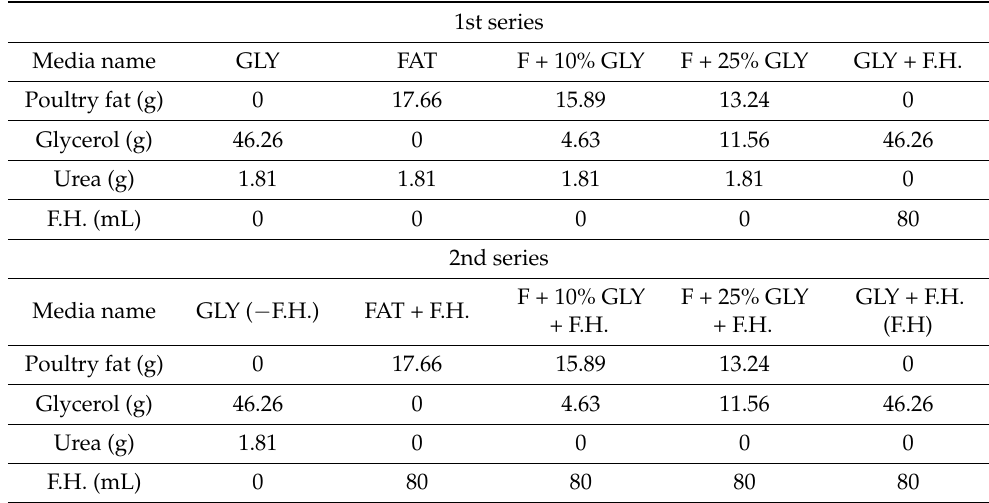
Table 2. Composition of production media at C/N ratio of 25 for volume of 1000 mL of media.